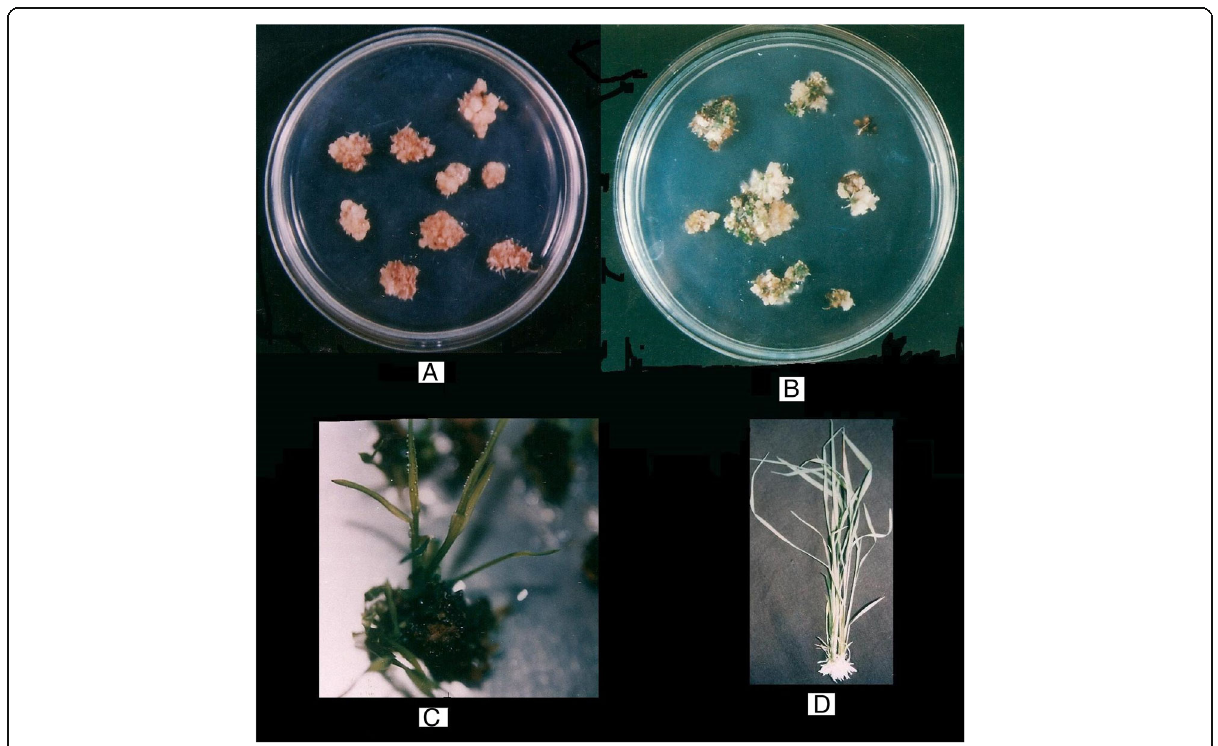
Fig. 1 Callus induction, somatic embryogenesis, and plant regeneration derived from mature embryo explants of rice. a Yellow-white callus. b Nodular callus. c Shoot formation. d Whole plant regeneration at the flowering